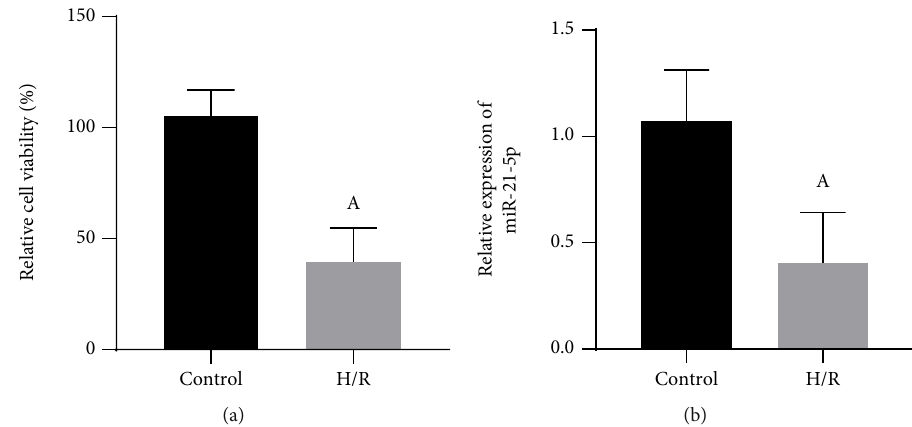
Figure 1: The e ff ect of H/R induction on the viability of HT22 cells and the expression of miR-21-5p ( n = 3 ). (a) Changes in the viability of HT22 cells under H/R conditions. (b) Changes in the expression of miR-21-5p in HT22 cells under H/R conditions. Note: Student ’ s t -test was used to compare the H/R group with the control group, a P < 0 : 05 .